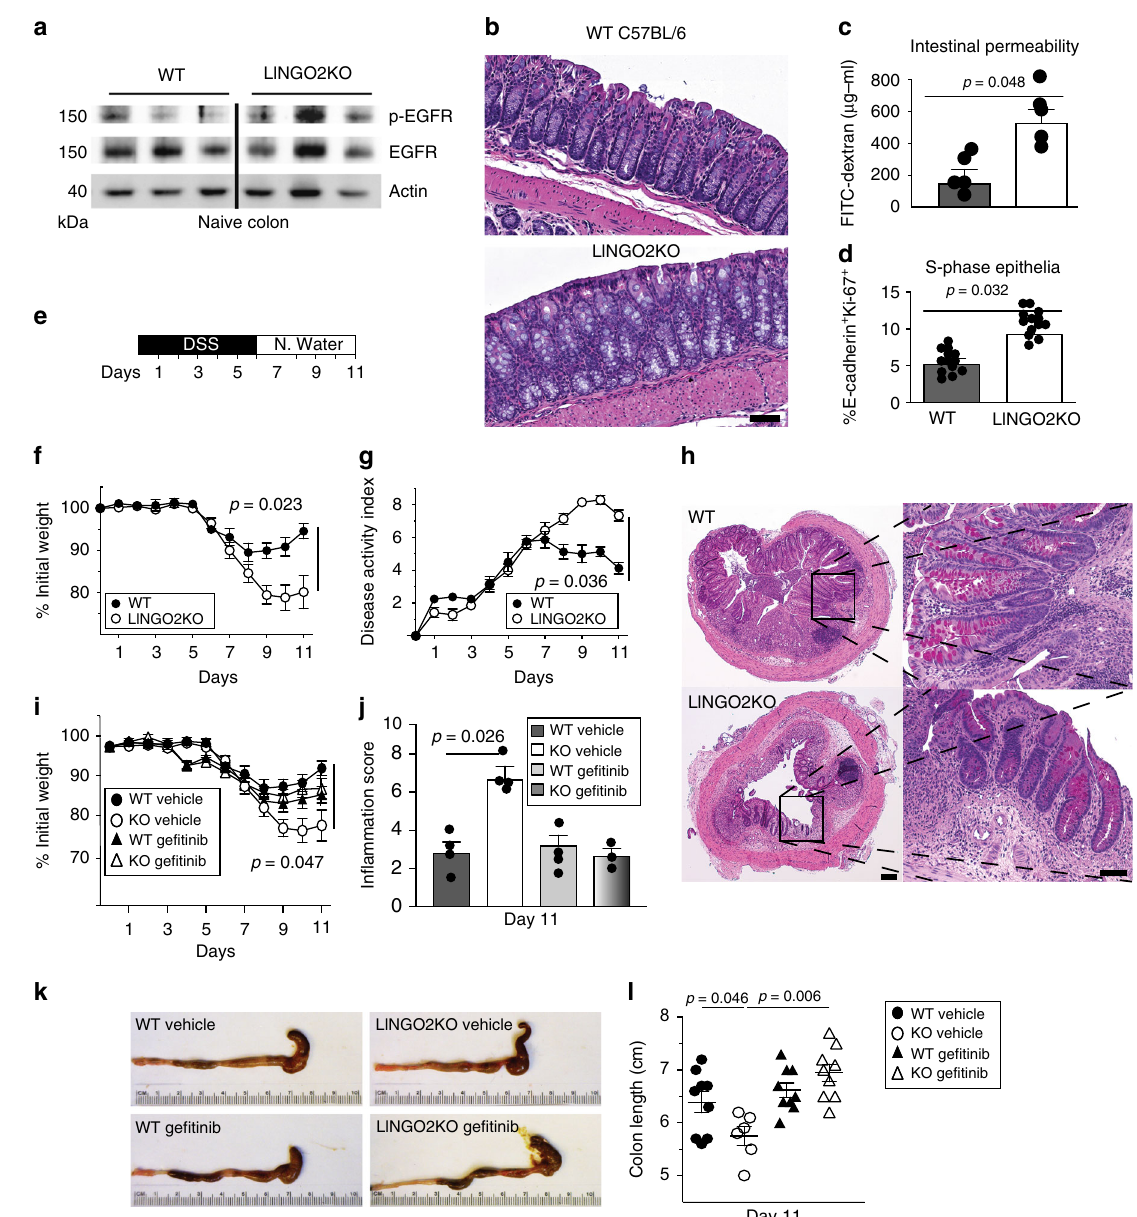
Fig. 3 LINGO2/EGFR axis controls DSS colitis severity. a Western blot showing phospo-EGFR (Y-1068) vs. total EGFR levels compared to beta-actin loading control in small intestinal lysates from individual WT vs. Lingo2 KO mice. Each lane is an individual mouse b H&E stained colon tissue from naive WT and Lingo2 KO mice. Magni fi cation ×40, scale bar 10 μ m. c Serum levels of FITC-Dextran in WT vs Lingo2 KO mice 4 h after oral gavage. d Percentage of small intestinal crypt cells per high power fi eld that stained double positive for E-cadherin and Ki-67 in naive WT vs Lingo2 KO mice. Mean ± SE of two independent experiments with the results of unpaired two tailed t tests shown. e Schematic of DSS treatment protocol. f Percent change from initial body weight caused by DSS administration at 2.5% w/v in cohorts of WT versus Lingo2 KO mice. g Disease activity index (DAI) clinical scores in WT versus Lingo2 KO mice from mice in f . Mean ± SE of 8 – 10 mice/group are shown. h H&E (left) and PAS (right) stain for WT and Lingo2 KO rectum 11 days post 2.5% DSS treatment. Representative images are shown. Magni fi cation ×4 (left) scale bar 100 μ m and ×40 (right) scale bar 10 μ m. i Change in initial body weight and j clinical in fl ammation score in WT versus Lingo2 KO mice post 2.5% DSS with or without Ge fi tinib treatment. Means ± SE of 8, 9 or 10 mice/ group are shown. k , l Colon length in WT versus Lingo2 KO - mice at day 11 post 2.5% DSS with or without Ge fi tinib. Means ± SE of 8, 9 or 10 mice/group and the results of two-way ANOVA analyses are